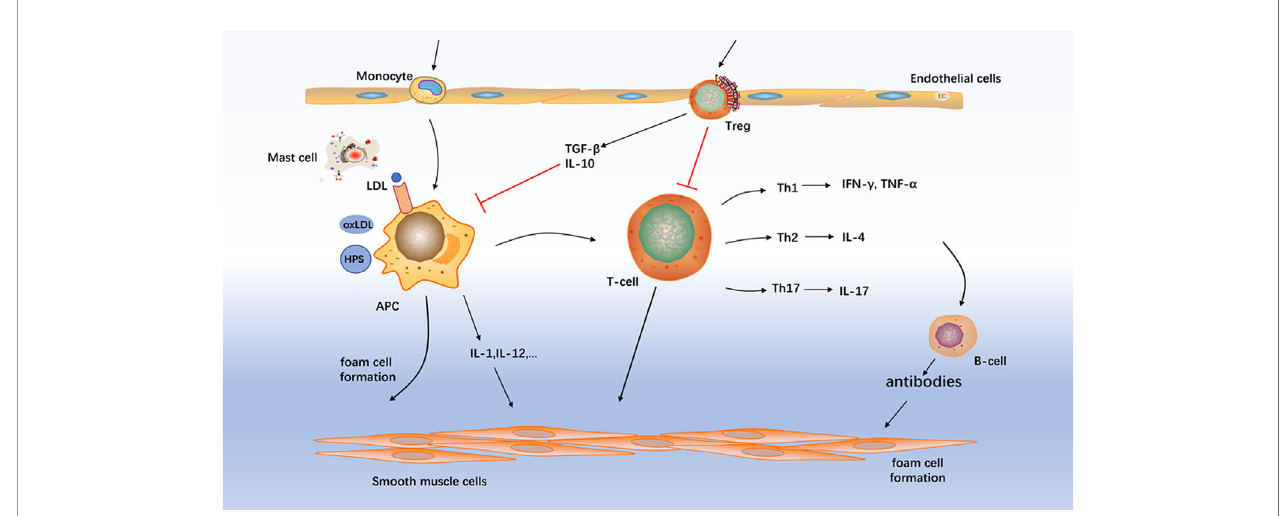
FIGURE 1 | Atherosclerosis mechanism. Several types of immunoreactive cells are present throughout atherosclerosis formation including macrophages, T cells, B cell, and mast cells. Treg, regulatory T-cell; APC, antigen-presenting cell; NK cell, natural killer